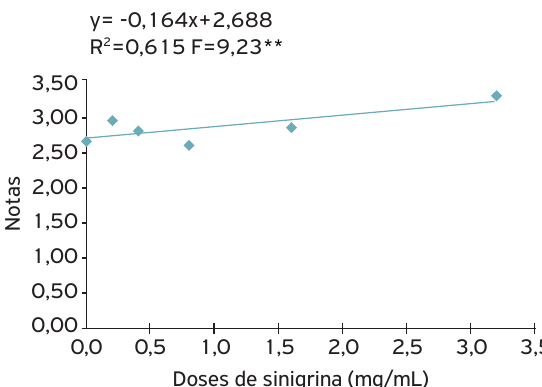
Figura 9. Curva ajustada para regressão polinomial entre as notas em função dos danos nas folhas de couve provocados por lagartas de Plutella xylostella e doses de sinigrina. Doses de Figura 10. Curva ajustada para regressão polinomial entre as notas em função dos danos nas folhas de brócolis provocados por lagartas de Plutella xylostella e doses de